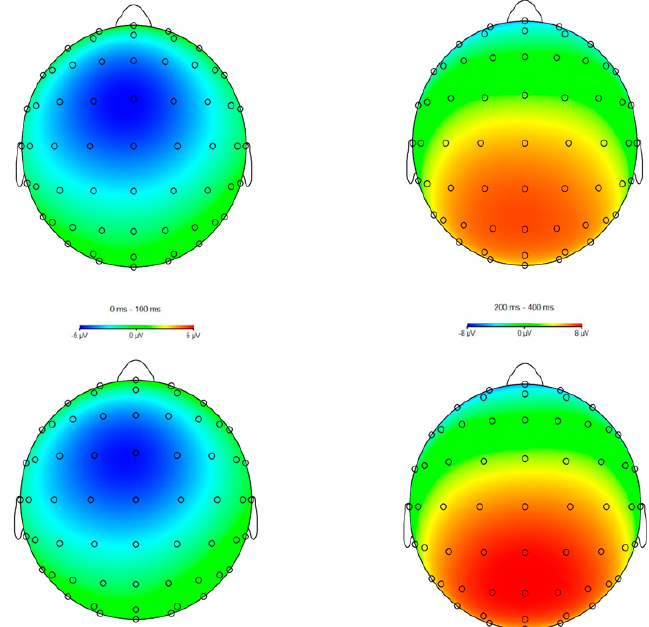
Figure 2. Scalp voltage maps for the error-minus-correct error-related negativity (ERN, left) and error positivity (Pe, right) as a function of group (control, top; meditation, bottom).